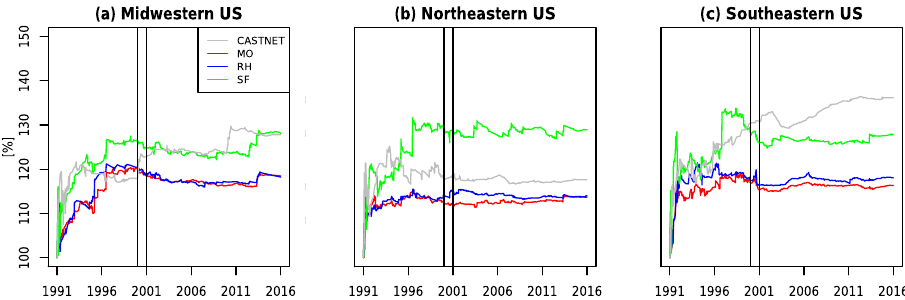
Figure 6. The relative difference (%) between the 99th percentile and the 90th percentile of JJA MDA8 O 3 for CASTNET and the three mechanisms over three regions as a function of increasing length of simulation, from 1 day up to the full 25 years simulated. The vertical bars indicate the year 2000, for which the emissions for all three simulations were